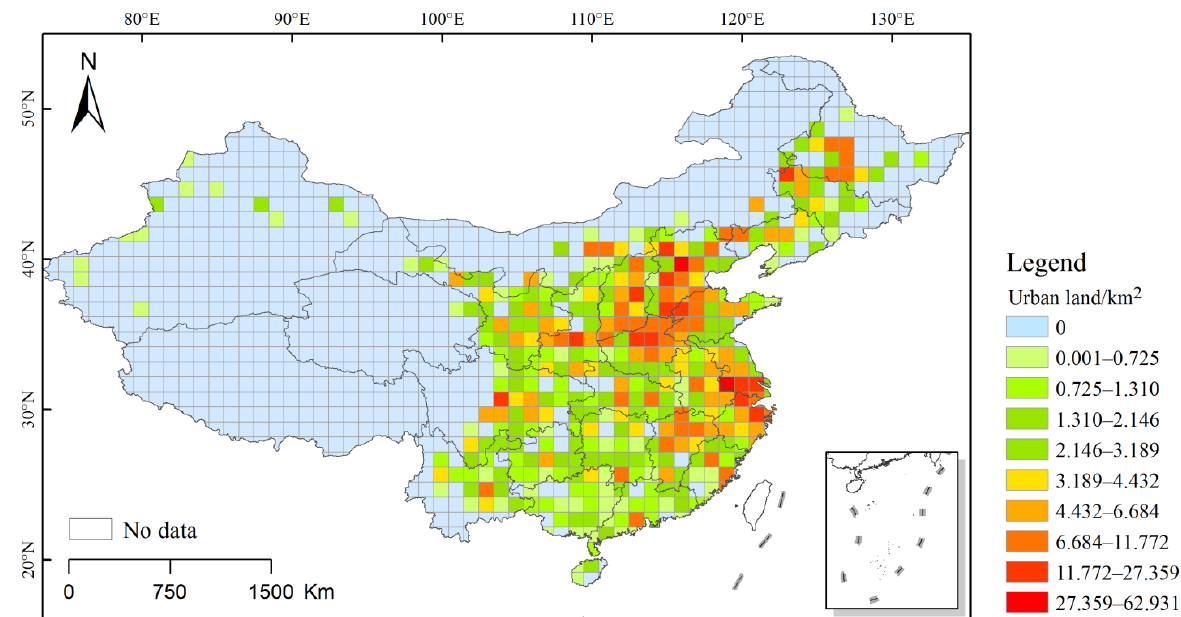
Figure 5. Reconstruction of the urban scale grid in the TCE.